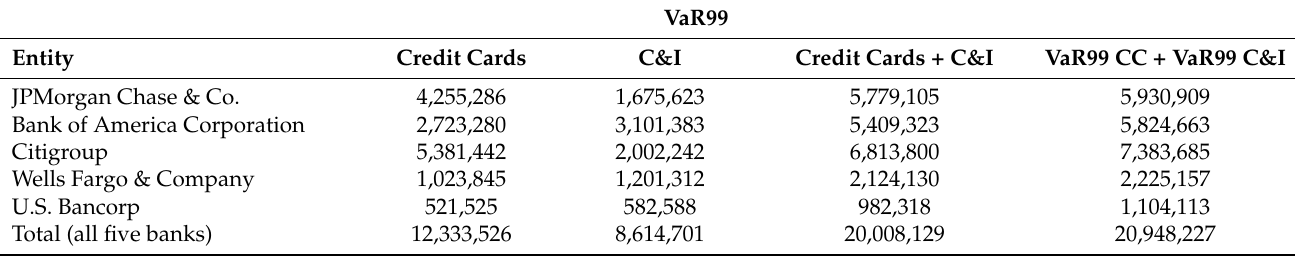
Figure 10. Total unexpected loss estimates. Left panel—one factor approach with 100% correlation. Right panel—unexpected (total) loss calculated with market factors’ correlation. Table 6. Nominal unexpected losses—simulation